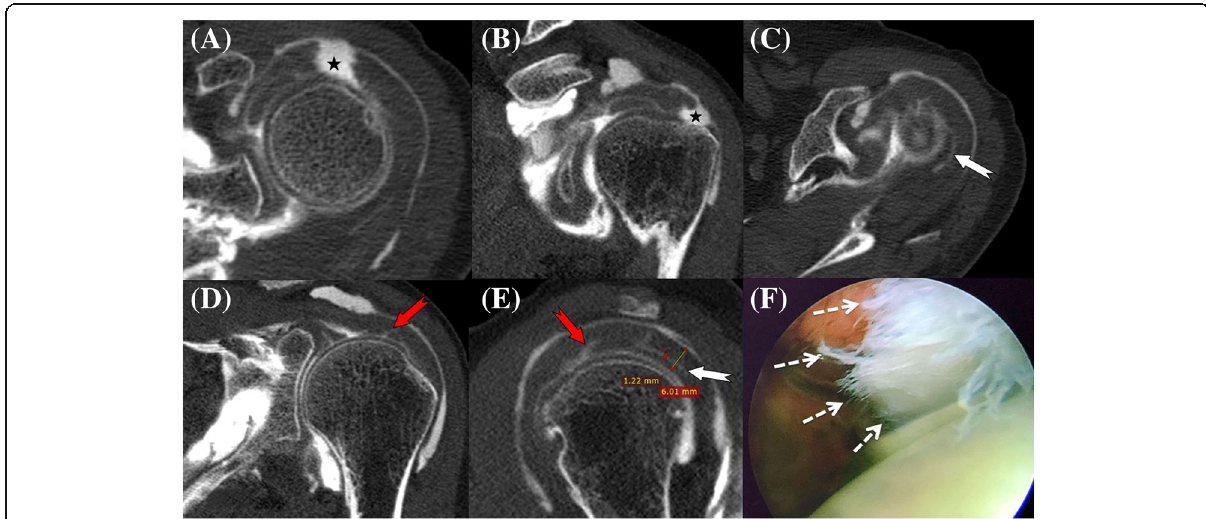
Fig. 4 CTA in 50 years old female patient complained from left shoulder weakness and pain increased on lifting or rotating her arm. Axial ( a ) and coronal oblique ( b ) images show full-thickness supraspinatus tendon tear (star) allow for bursal contrast passage and cancelation of bursal injection. More cephalic axial image ( c ) with more posterior coronal oblique image ( d ) and sagittal oblique CT arthrographic image ( e ) demonstrate interstitial extension into the remaining supraspinatus tendon (red arrow) and thin articular surface infraspinatus tendon tear extending interstitially (white arrow). Arthroscopic image ( f ) shows full - thickness supraspinatus tendon tear with frayed edges (arrows)